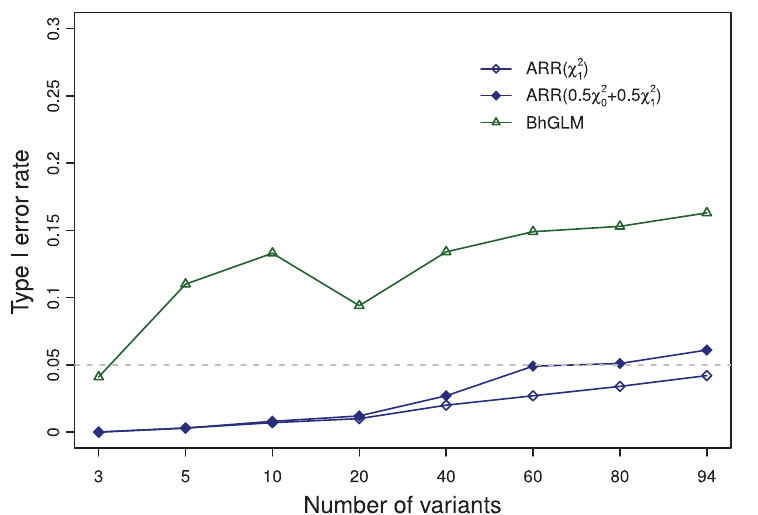
Figure 2. Type I error rates of the ARR and BhGLM methods obtained from the simulation studies. The Type I error rate of the Bayesian hierarchical generalized linear model (BhGLM) method was calculated using a threshold of 3.84 for the Wald test statistic. The Type I error rates of the adaptive ridge regression (ARR) method were calculated using thresholds of 3.84 and 2.71, respectively, corresponding to the x 2 0 : 5 x